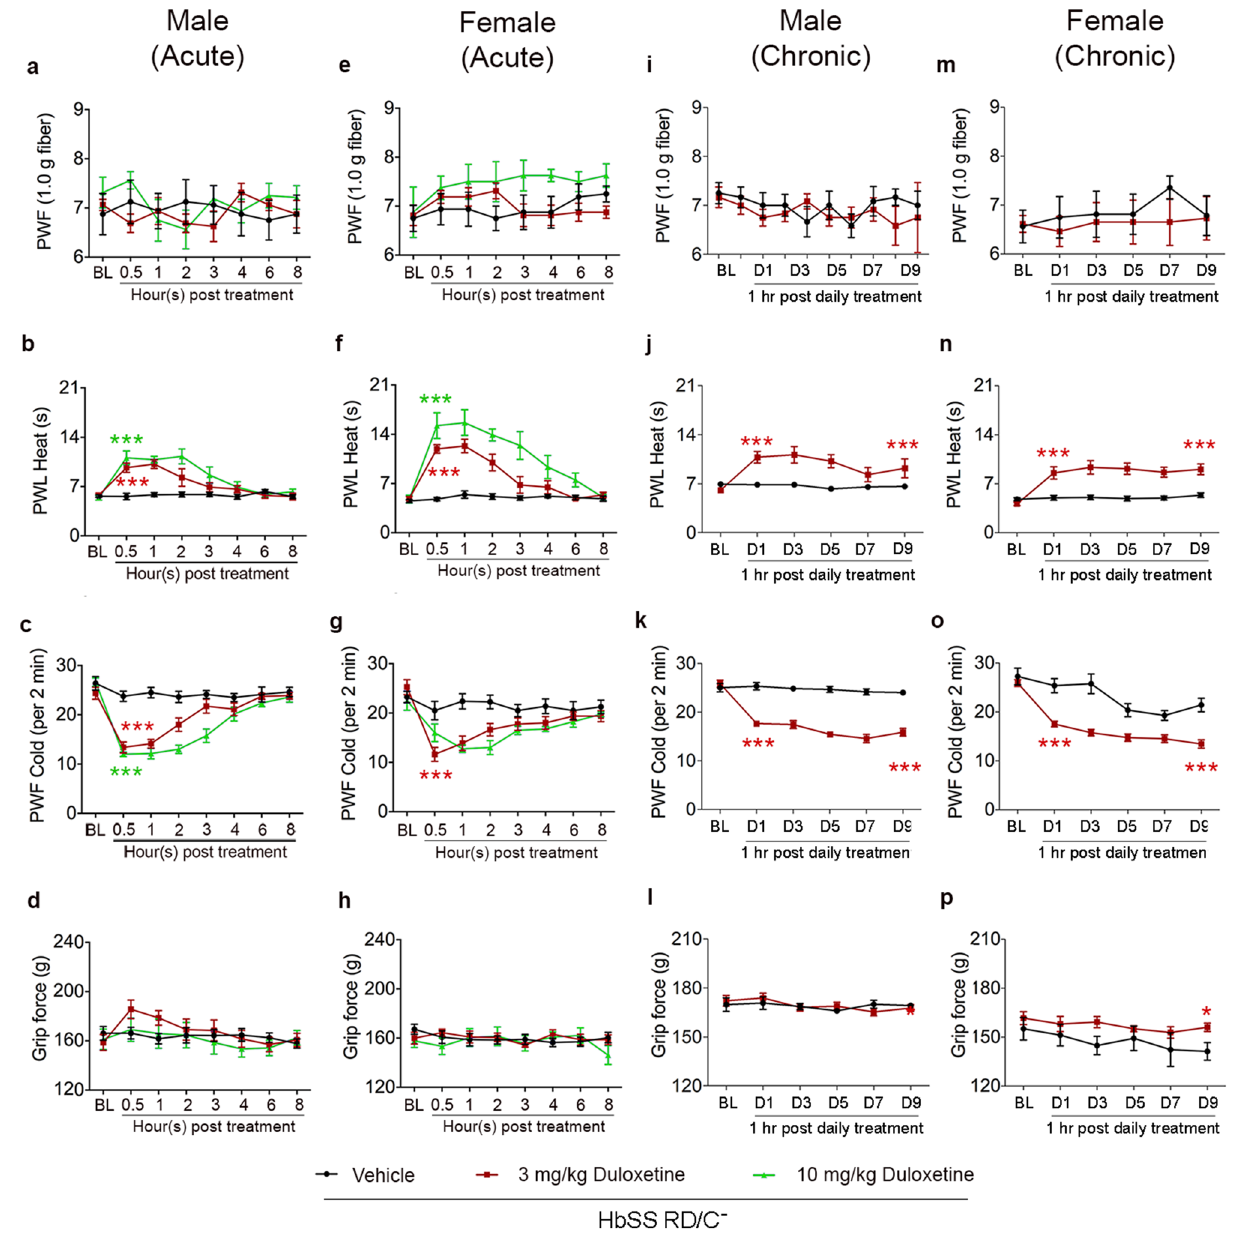
Figure 4. Effect of acute and chronic duloxetine treatment on hyperalgesia in male and female sickle mice. All mice were fed regular diet and housed singly without a companion. Hyperalgesia measures for all mice are shown for, mechanical hyperalgesia as PWF in response to 1.0 g von Frey filaments; heat hyperalgesia as PWL in response to a heat stimulus; cold hyperalgesia as PWF per 2 min on a cold plate at 4 °C and deep tissue/ musculoskeletal hyperalgesia as grip force exerted by forelimbs. Effect of an acute single dose of duloxetine at 3 and 10 mg/Kg or vehicle ( a – h ) and of chronic administration of 3 mg/Kg/day duloxetine or vehicle for 9 days ( i – p ), in male and female sickle mice on hyperalgesia. Acute duloxetine treatment in male sickle mice ( a – d ), nSS vehicle = 8, nSS 3 mg/kg duloxetine = 8, nSS 10 mg/kg duloxetine = 8; Acute duloxetine treatment in female sickle mice ( e – h ), nSS vehicle = 8, nSS 3 mg/kg duloxetine = 8, nSS 10 mg/kg duloxetine = 4; Chronic duloxetine treatment in male sickle mice ( i – l ), nSS vehicle = 6, nSS 3 mg/kg duloxetine = 6; Chronic duloxetine treatment in female sickle mice ( m – p ), nSS vehicle = 8, nSS 3 mg/kg duloxetine = 13; mixed linear models with Tukey’s post- hoc test, * p < 0.05, *** p < 0.001 compared to vehicle. D1, D3, D5, D7, and D9, day 1, 3, 5, 7, and 9 respectively; PWF, paw withdrawal frequency; PWL, paw withdrawal